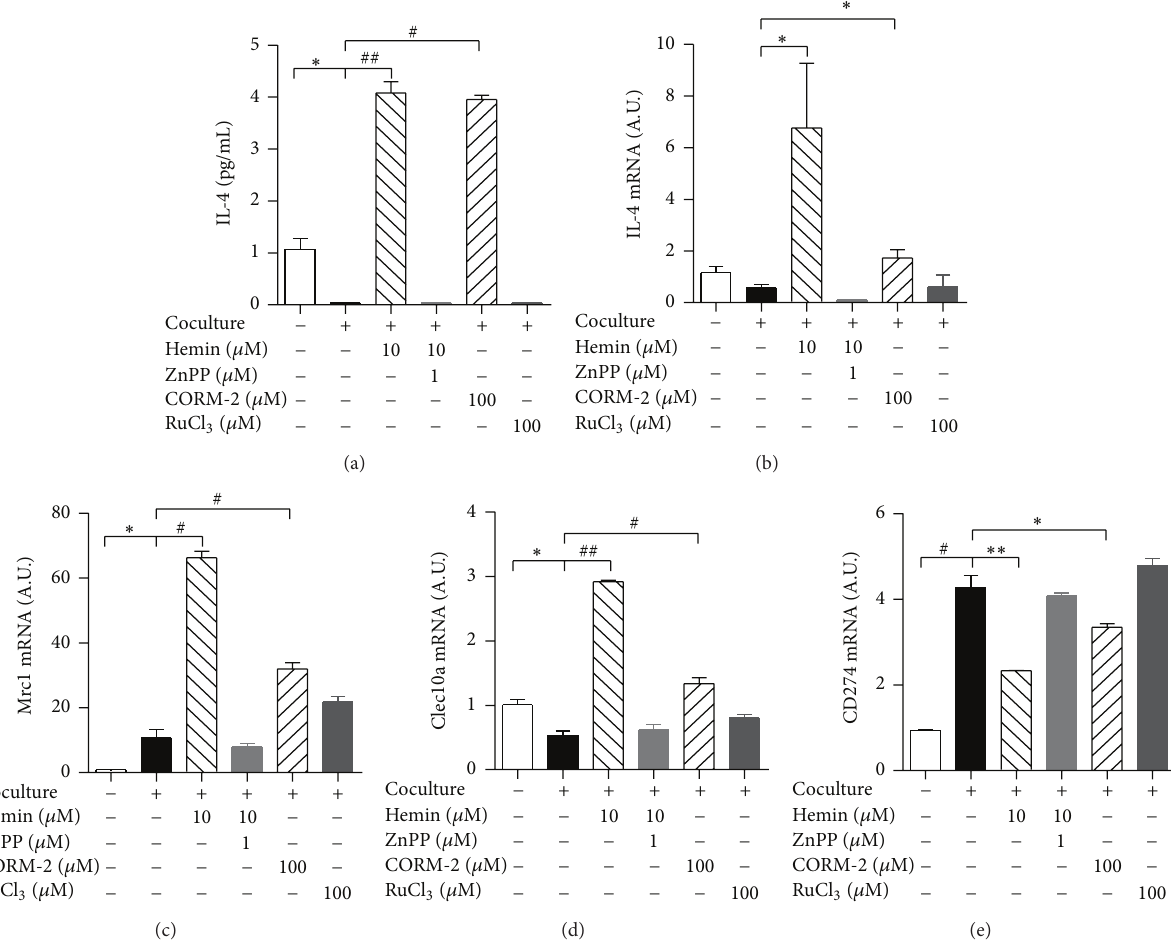
Figure 3: HO-1 induction alters macrophage polarization in cocultures. Raw264.7 macrophages were seed onto 3T3-L1 adipocytes with/without being pretreated with the indicated concentrations of hemin or CORM-2 for 12h. (a) IL-4 levels in hemin/CORM-2-treated cocultures. (b) Total RNAs were isolated and the level of IL-4 was analyzed by qRT-PCR. Transcript levels of the M2 markers Mrc1 (c) and Clec10a (d) and the M1 marker (CD274) (e) were detected by qRT-PCR; 𝛽 -actin was used as control gene. The experiment was performed in duplicate. Results are means ± SEM. ∗ 𝑃 < 0.05 , ∗∗ 𝑃 < 0.01 , # 𝑃 < 0.005 , and ## 𝑃 < 0.001 . A.U.: arbitrary